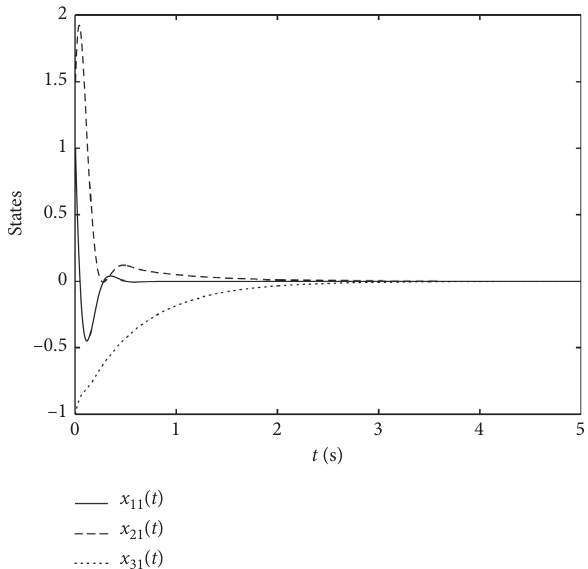
Figure 4: Control results of the fractional order nonlinear interconnected system.